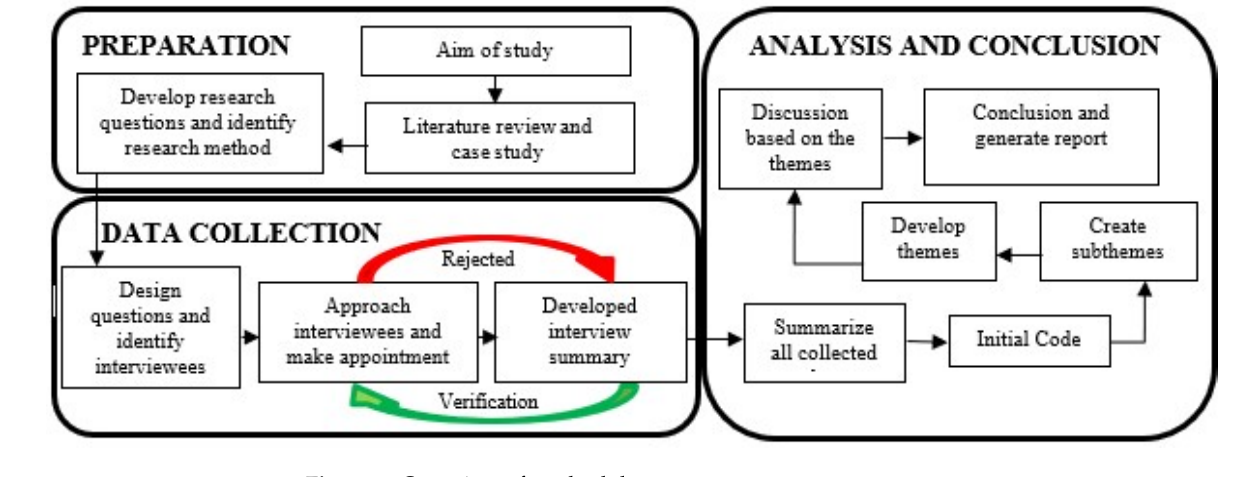
Figure 2. Overview of methodology.